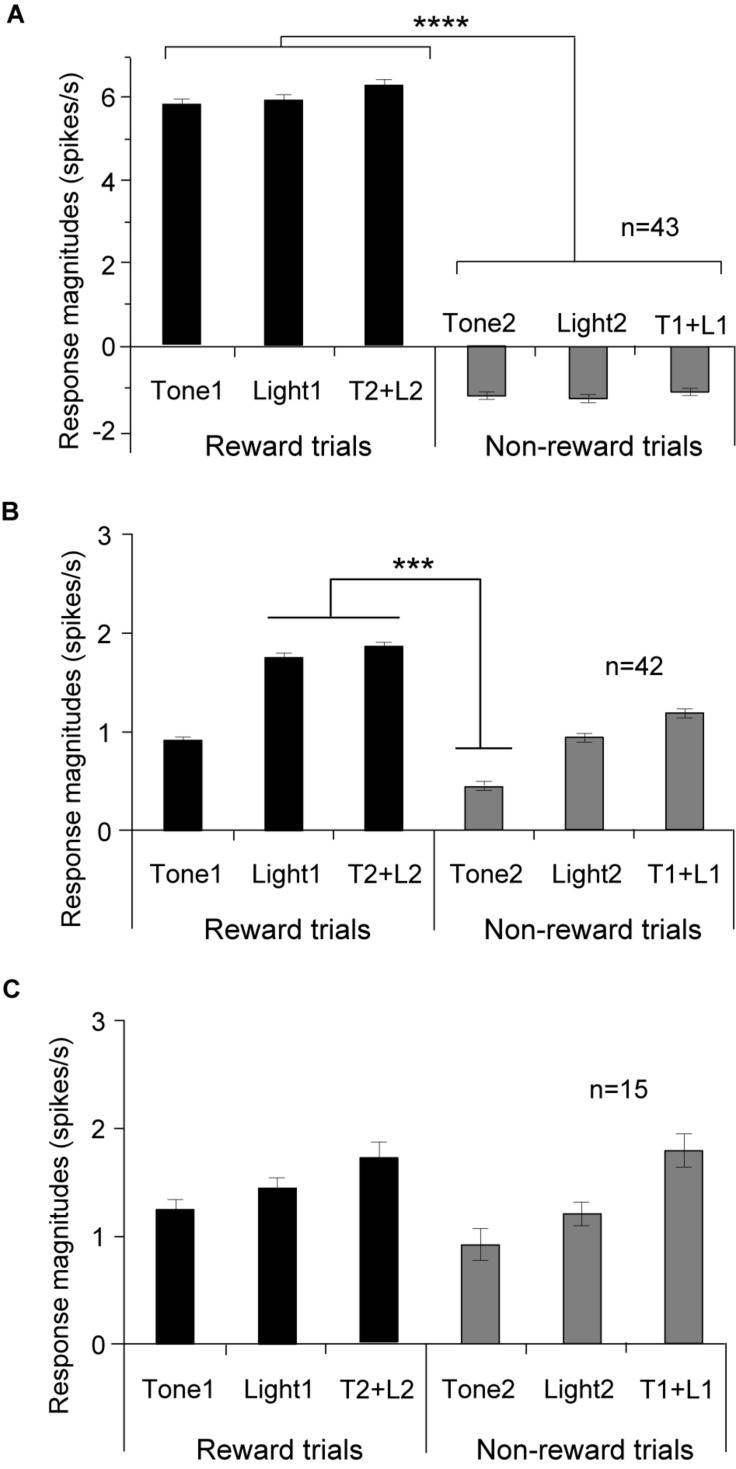
Comparison of the mean response magnitudes (mean firing rates ± standard error of the mean, SEM) to the CSs in the three subcategories of the CS-responsive neurons. (A) CS+-selective neurons (n = 43). Response magnitudes to the rewarding CSs are significantly greater than those to the non-rewarding CSs. (B) Other differential CS-responsive neurons (n = 42). (C) Non-differential CS-responsive neurons (n = 15). ****p < 0.0001; ***p < 0.001 (Bonferroni tests).